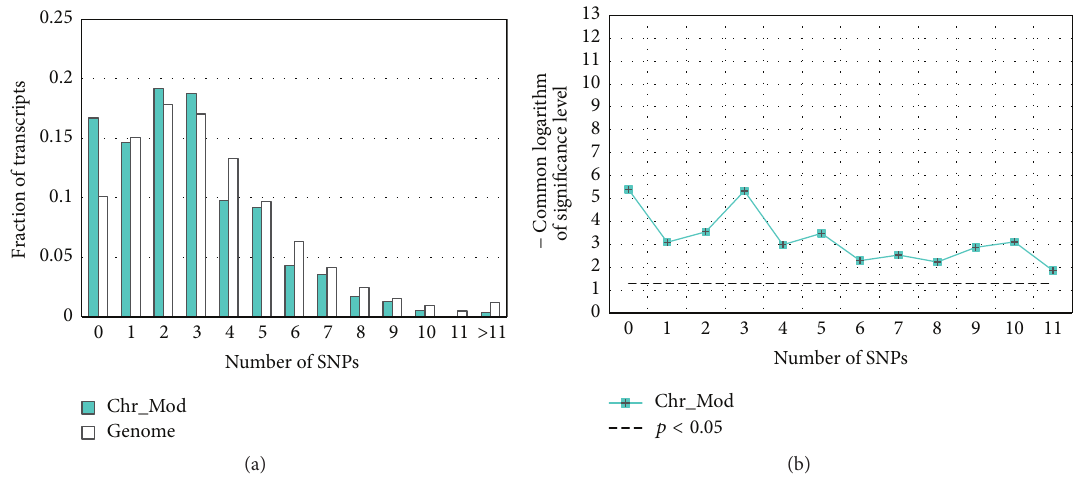
Figure 4: Comparison of SNP content distributions in upstream regions of human genes encoding chromatin-modifying proteins with the distribution in the whole-genome dataset (Table 1). The 5 󸀠 -regulatory regions between − 600 and +100bp around TSSs are analyzed. The dataset of chromatin-modifying proteins genes/transcripts was extracted from EntrezGene, CREMOFAC [10], and CR Cistrome Databases [11]. In panel (a), the 𝑥 -axis denotes the SNP content, and the 𝑦 -axis denotes the fraction of transcripts with specific content of SNPs in their 5 󸀠 -regulatory regions. Panel (b) presents the significance of the 𝑡 -test ( 𝑦 -axis), which compares the SNP contents in test group with the content in the whole-genome dataset as a function of the threshold of SNP content ( 𝑥 -axis). The 𝑡 -test was applied as described in Section 2.